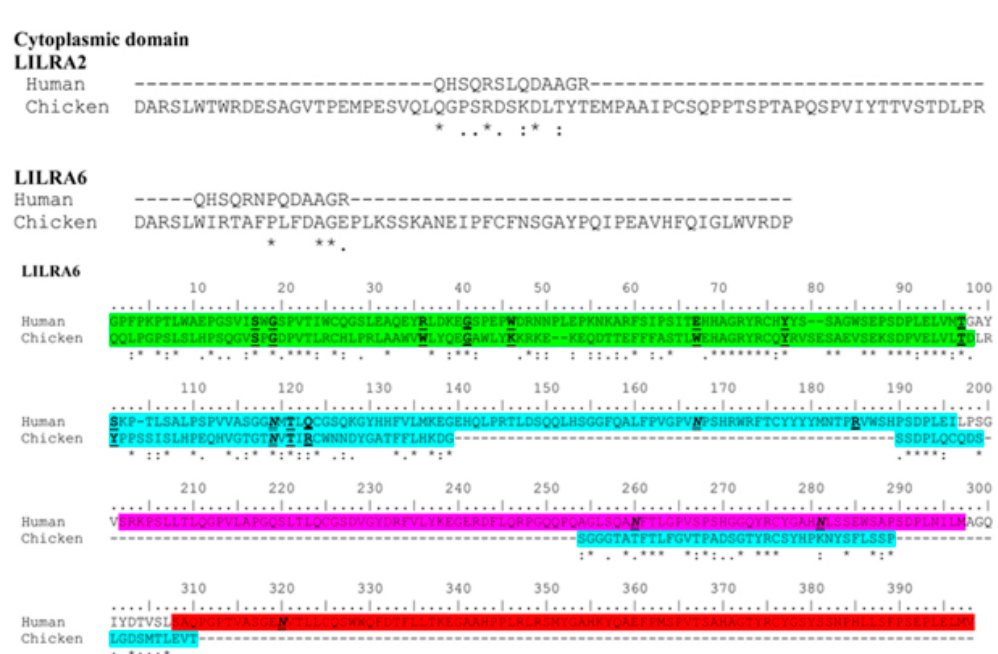
Figure 1. Phylogenetic and sequence alignment analysis of chicken LILRA2 and LILRA6. ( A ) Phylogenetic tree indicating the relationships of chicken LILRA2 and LILRA6 with mammalian LILRA2 and LILRA6; ( B ) Multiple sequence alignment of the predicted chicken LILRA2 and LILRA6 with human LILRA2 and LILRA6. Asterisks (*) indicate identical amino acid residues. Single dots (.) indicate homologous amino acid changes and double dots (:) indicate conserved amino acid changes. N-linked glycosylation sites and binding site are indicated in italic-underline and bold-underline, respectively. Four Ig domains (D1–D4 domains) are indicated in green, turquoise, pink and red color, respectively.